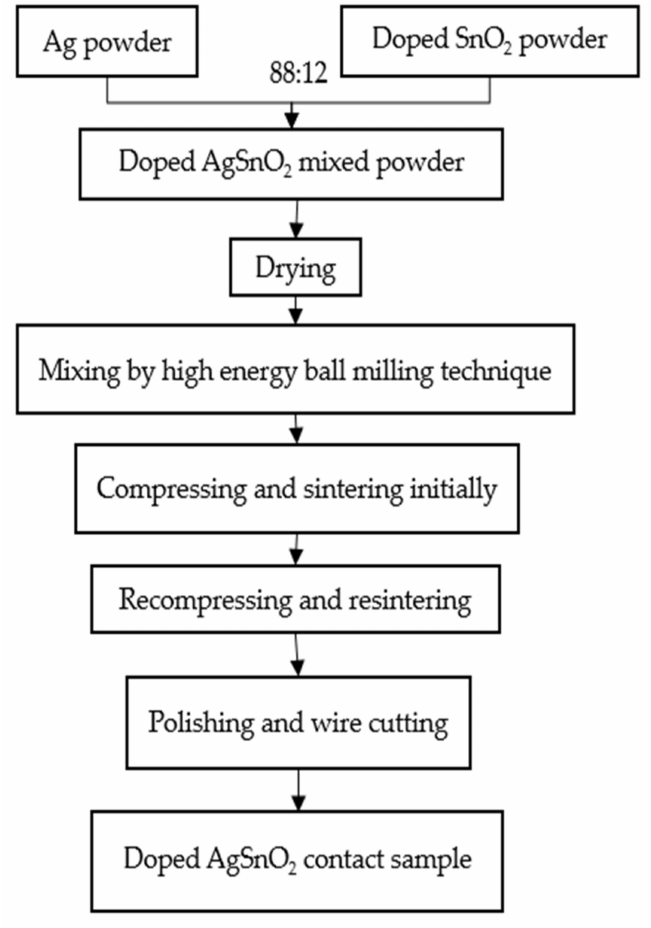
Figure 3. Process of doped AgSnO 2 contact material preparation by powder metallurgy. Table 2. Experimental